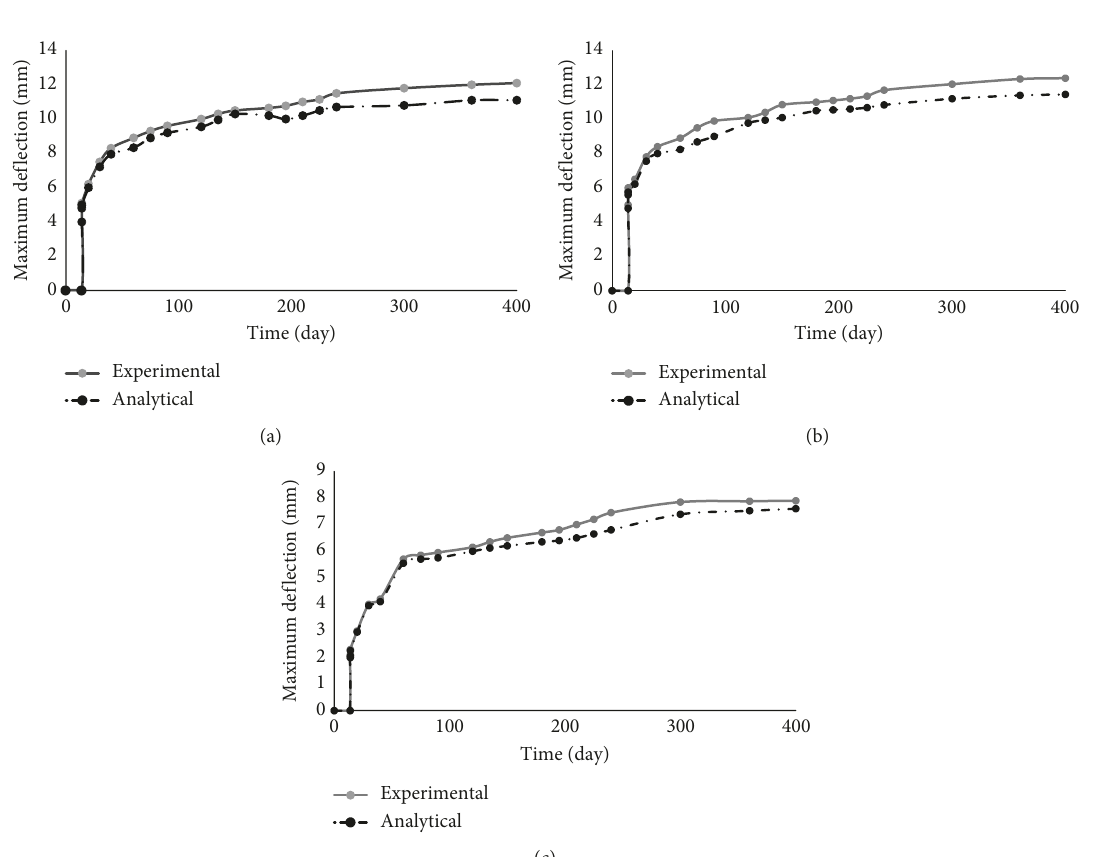
Figure 1: Geometry of the cross sections of beams.